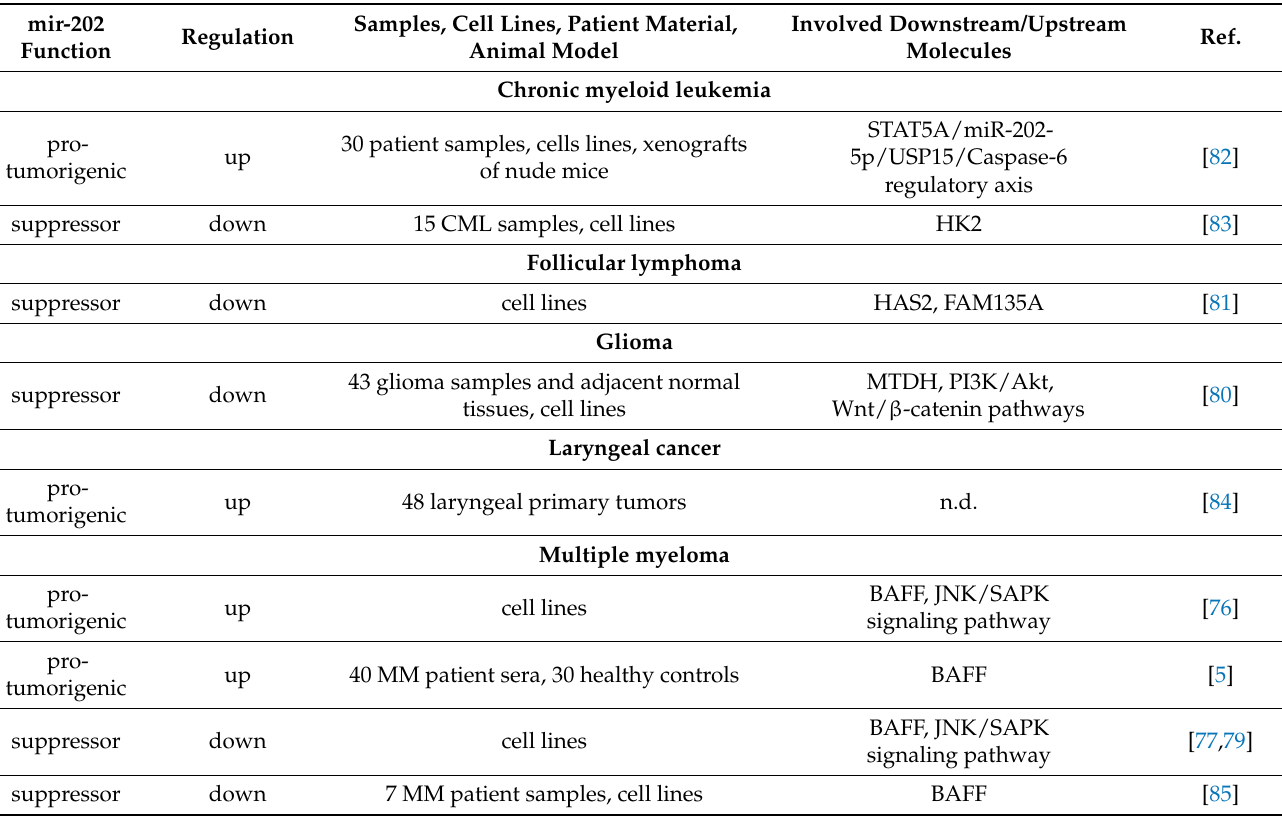
Table 6. miR-202 as a tumor suppressor in other types of